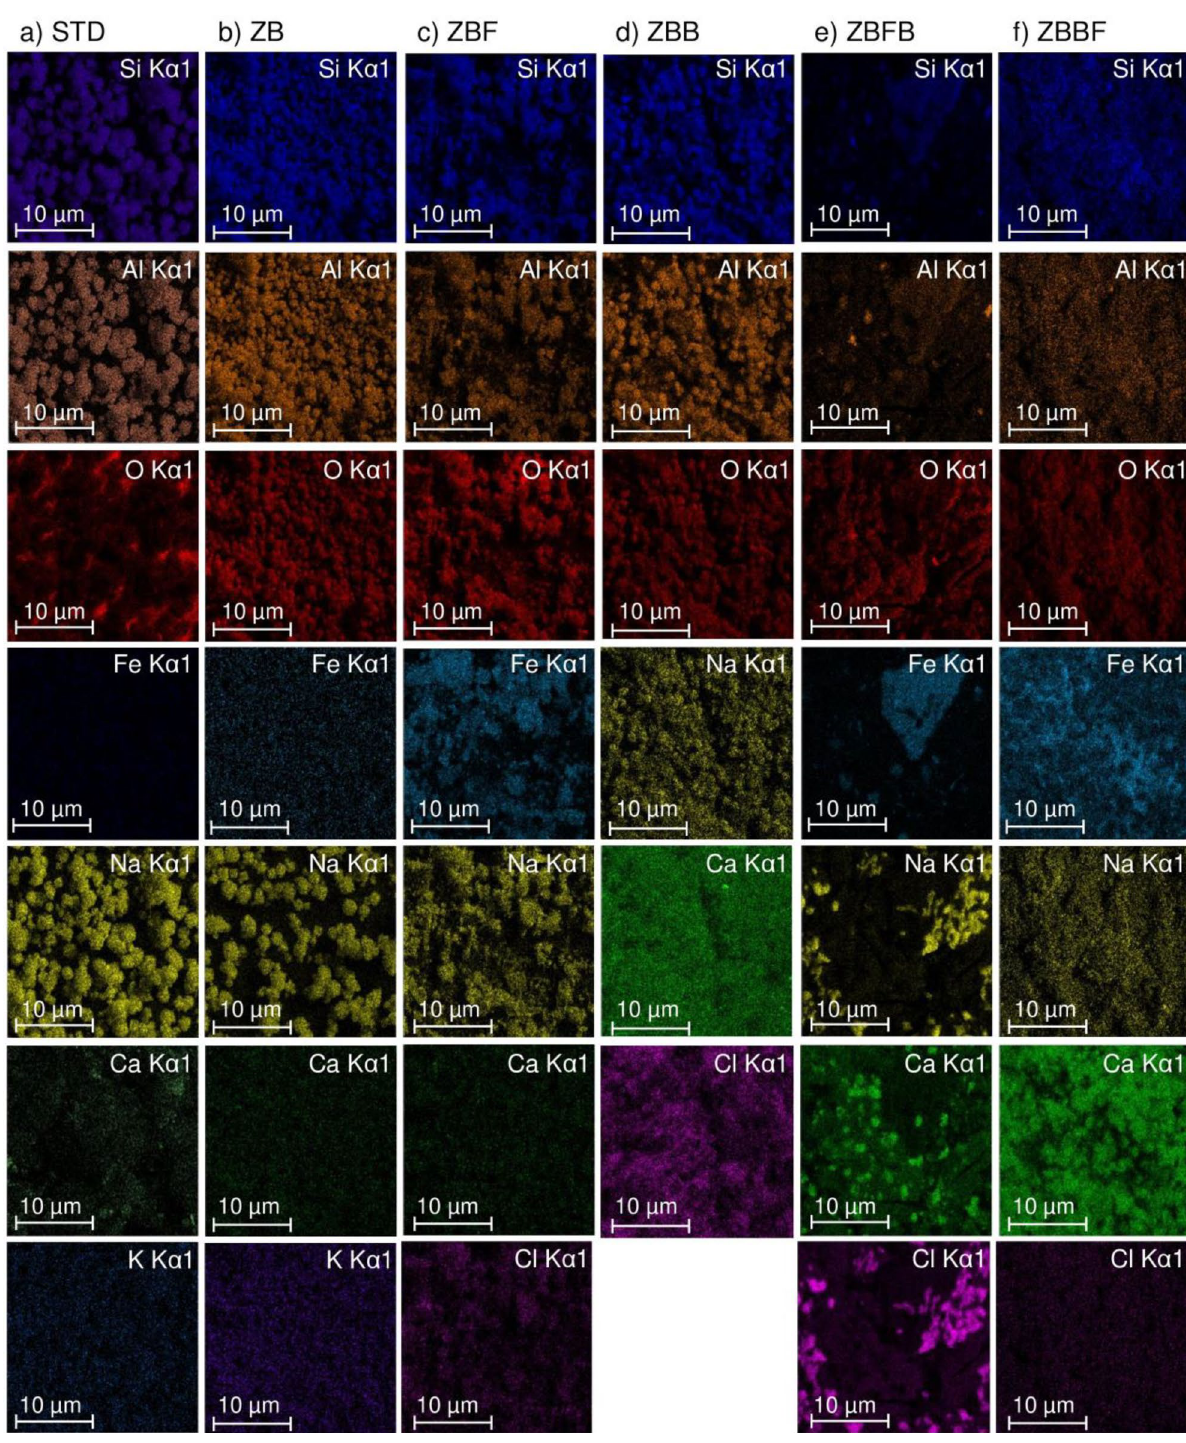
Figure 4. The elemental mapping of ( a ) zeolite A standard (STD), ( b ) zeolite A sugarcane bagasse fly ash powder (ZB), ( c ) zeolite A sugarcane bagasse fly ash powder mixed iron(III) oxide-hydroxide (ZBF), ( d ) zeolite A sugarcane bagasse fly ash beads (ZBB), ( e ) zeolite A sugarcane bagasse fly ash powder mixed iron(III) oxide- hydroxide beads (ZBFB), and ( f ) zeolite A sugarcane bagasse fly ash beads coated iron(III) oxide-hydroxide (ZBBF) on the